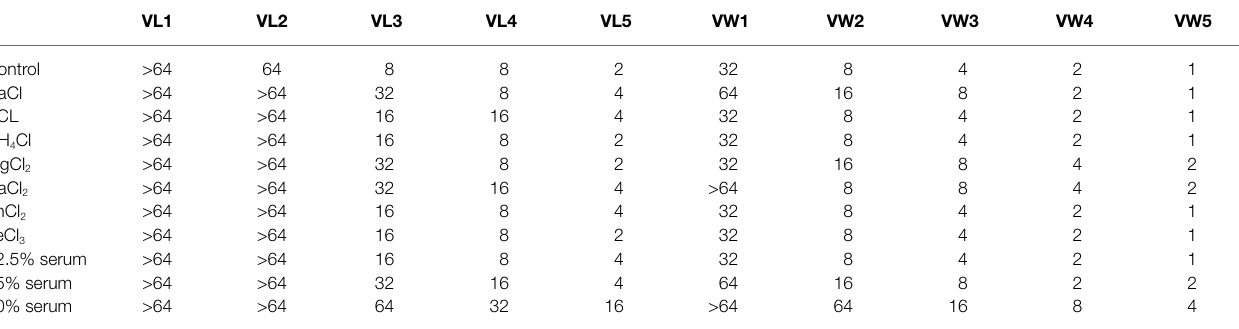
TABLE 4 | MICs ( μ M) of peptides against P. aeruginosa in the presence of salts a and